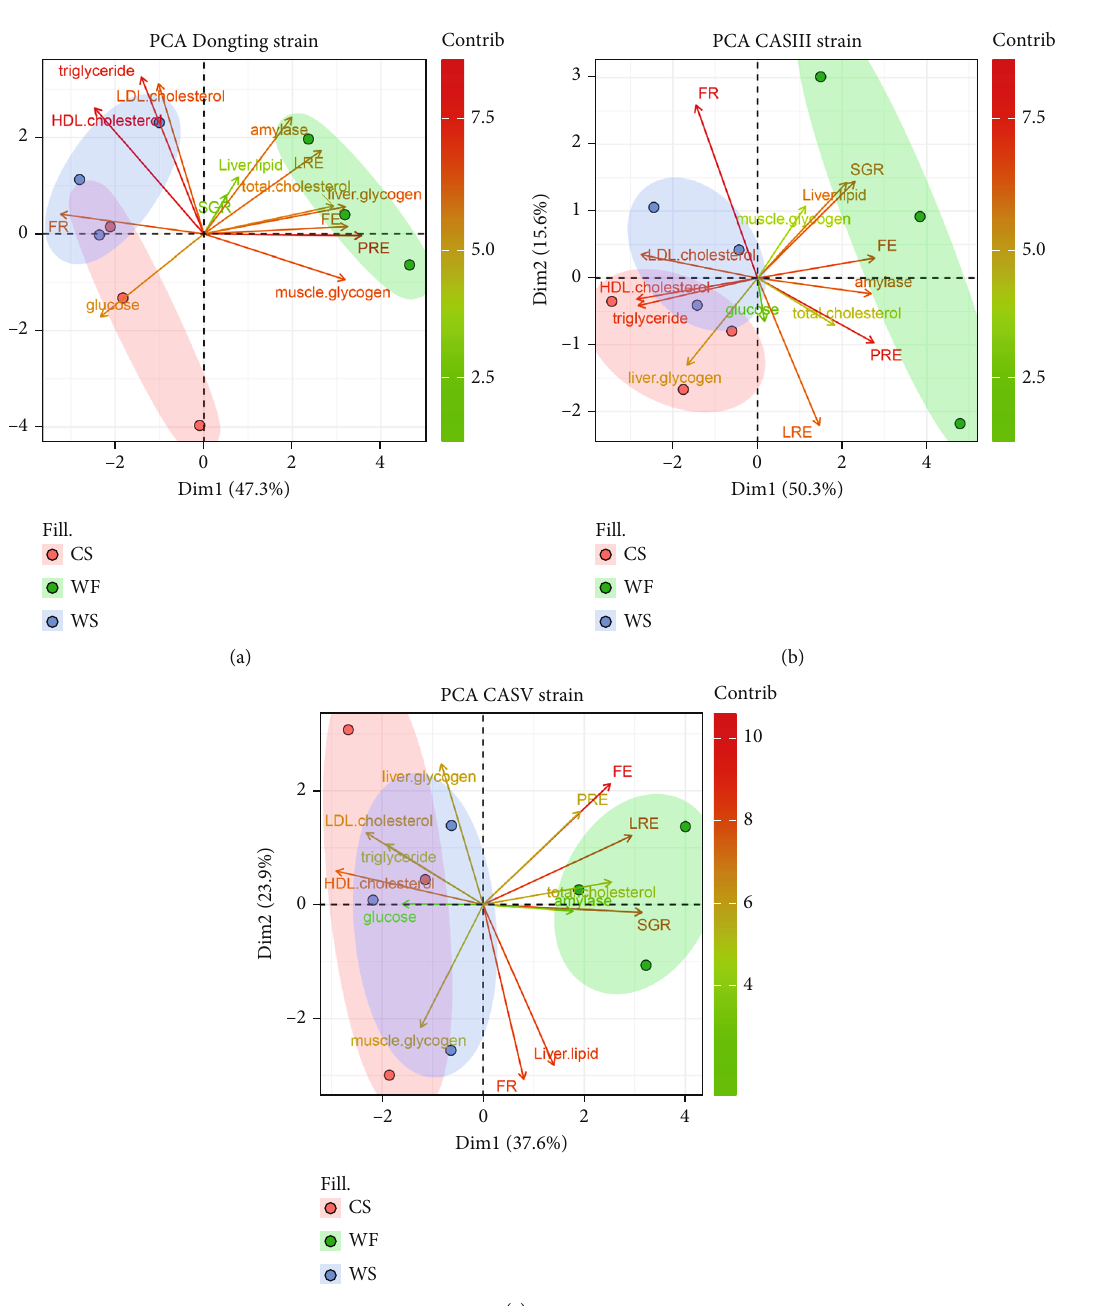
Figure 4: Principal component analysis (PCA) biplot of physiological responses from each strain of gibel carp fed three dietary carbohydrate sources. (a) The physiological responses of Dongting fed CS, WF, and WS. (b) The physiological responses of CASIII fed CS, WF, and WS. (c) The physiological responses of CASV fed CS, WF, and WS. Arrows indicate the direction of increasing values for each variable. Colour coding indicates cluster membership determined by K -means clustering based on their scores on the main PCA